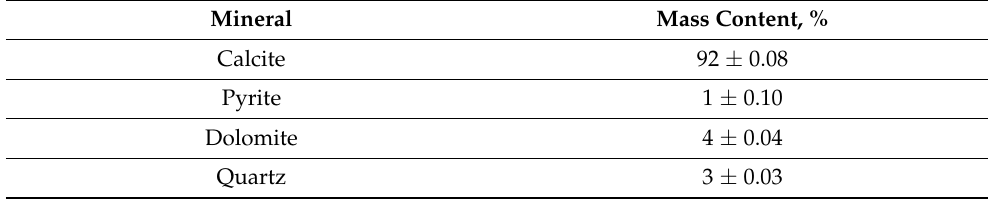
Figure 6. Diffractogram of the original core sample. Table 4. Mineral composition of the rock. Mineral